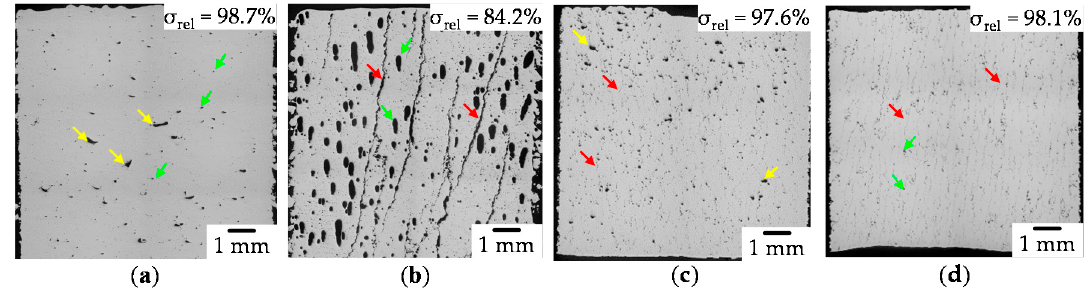
Figure 9. Cross-section (optical microscopy) of different specimens with the highest relative density of set 1–4 ( a ) P L = 200 W, v s = 83.3 mm/s, Δ y = 70 µm, T pre = 20 °C ( b ) P L = 200 W, v s = 83.3 mm/s, Δ y = 70 µm, T pre = 350 °C ( c ) P L = 300 W, v s = 1240 mm/s, Δ y = 78 µm, T pre = 20 °C K ( d ) P L = 400 W, v s = 2820 mm/s, Δ y = 83 µm, T pre = 300 °C. Yellow arrows mark insufficient melting, green gas porosity and red hot cracks.